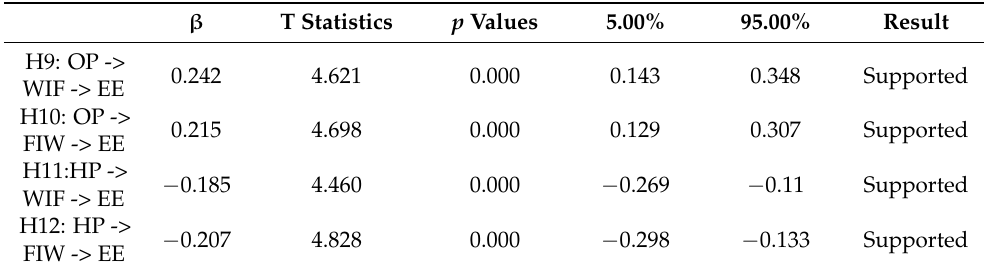
Table 5. Results of the indirect